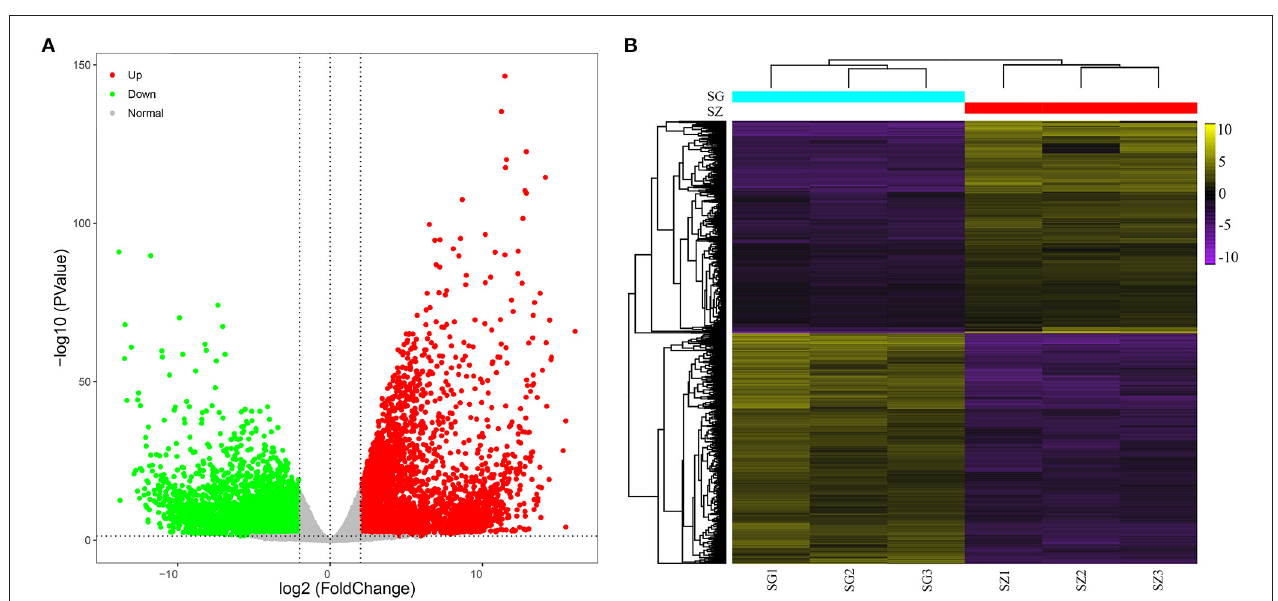
FIGURE 2 | Analysis of differentially expressed genes. (A) Volcano plot of differentially expressed genes between SG and SZ libraries, red and green dots represent the significantly upregulated and downregulated genes, respectively. (B) Heat map of differentially expressed genes between SG and SZ libraries based on hierarchical clustering